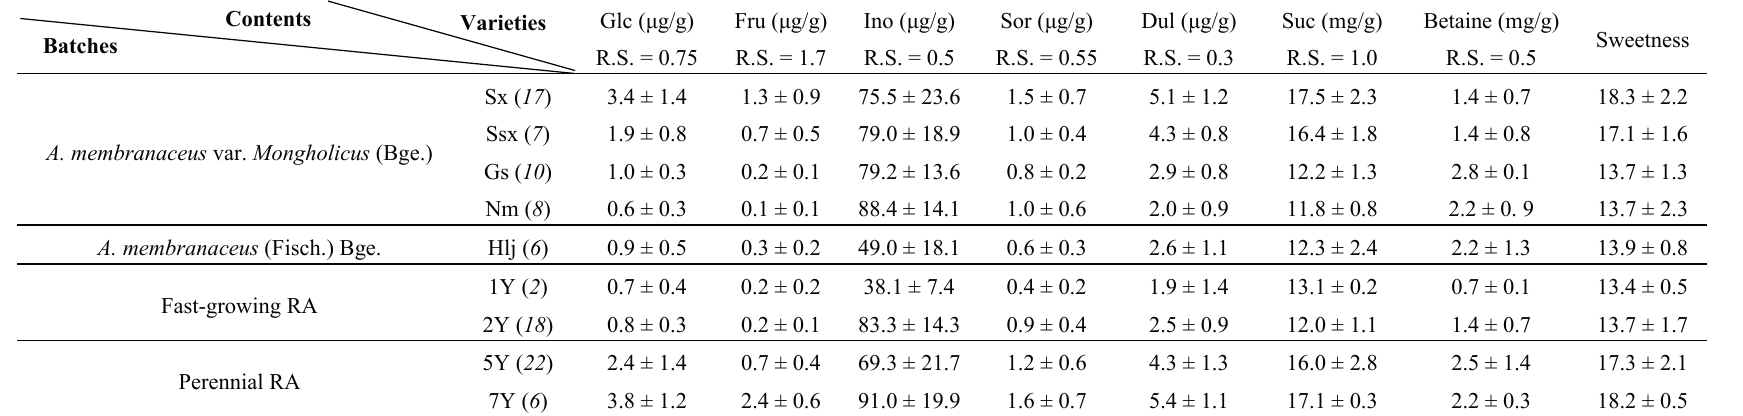
Table 1. Contents of the seven components that affect RA